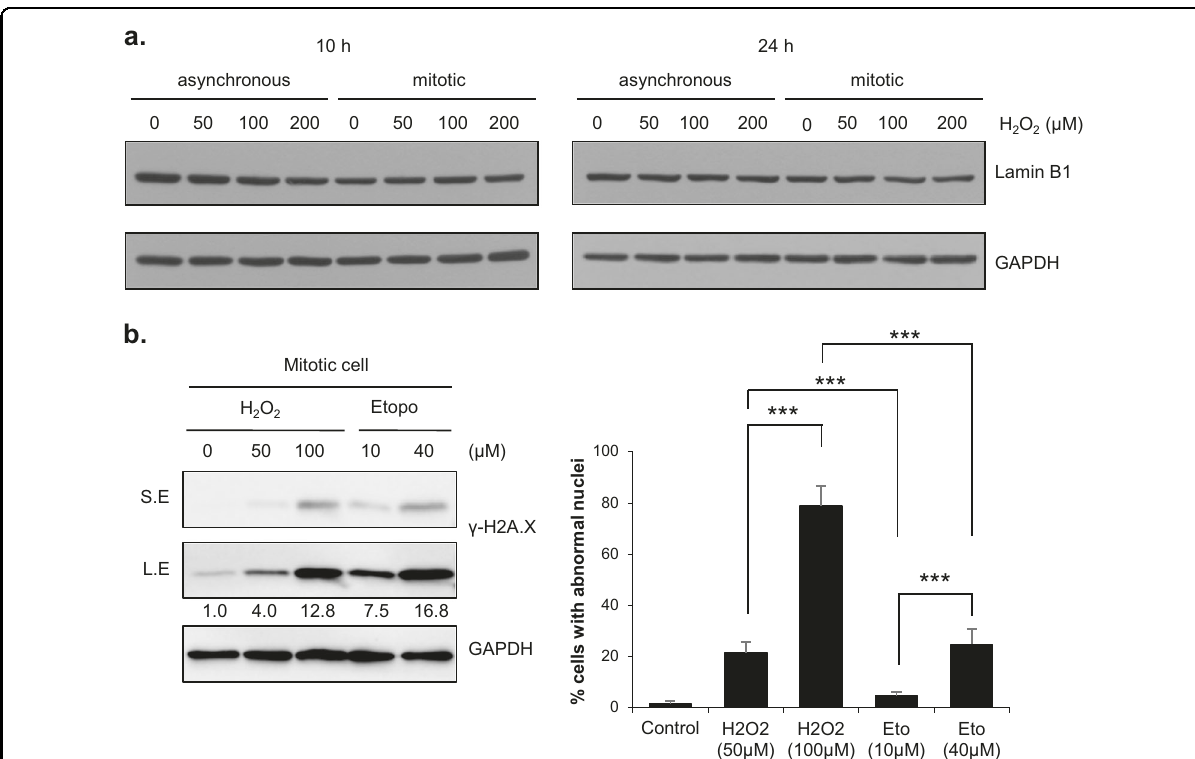
Fig. 3 H 2 O 2 -induced abnormal nuclear shapes are mainly due neither to changes in the Lamin B1 level nor to DNA damage. a Asynchronous or mitotic HeLa cells were treated with H 2 O 2 at the indicated concentrations for 10 h or 24 h. Cell lysates were harvested and subjected to western blot analysis by using the indicated antibodies. b Mitotic HeLa cells were treated with H 2 O 2 or etoposide at the indicated concentrations. Left panel: Mitotic cells were cotreated with H 2 O 2 or etoposide and 100 ng/ml nocodazole for 1 h and subjected to western blot analysis with the indicated antibodies. Right panel: Mitotic HeLa cells were treated with H 2 O 2 or etoposide for 10 h, and the percentage of cells with abnormal nuclear shapes was then determined. The results are shown as the means ± SDs of three independent experiments ( n = 300). *** P < 0.001 by Student ’ s t -test. S.E. short exposure; L.E. long